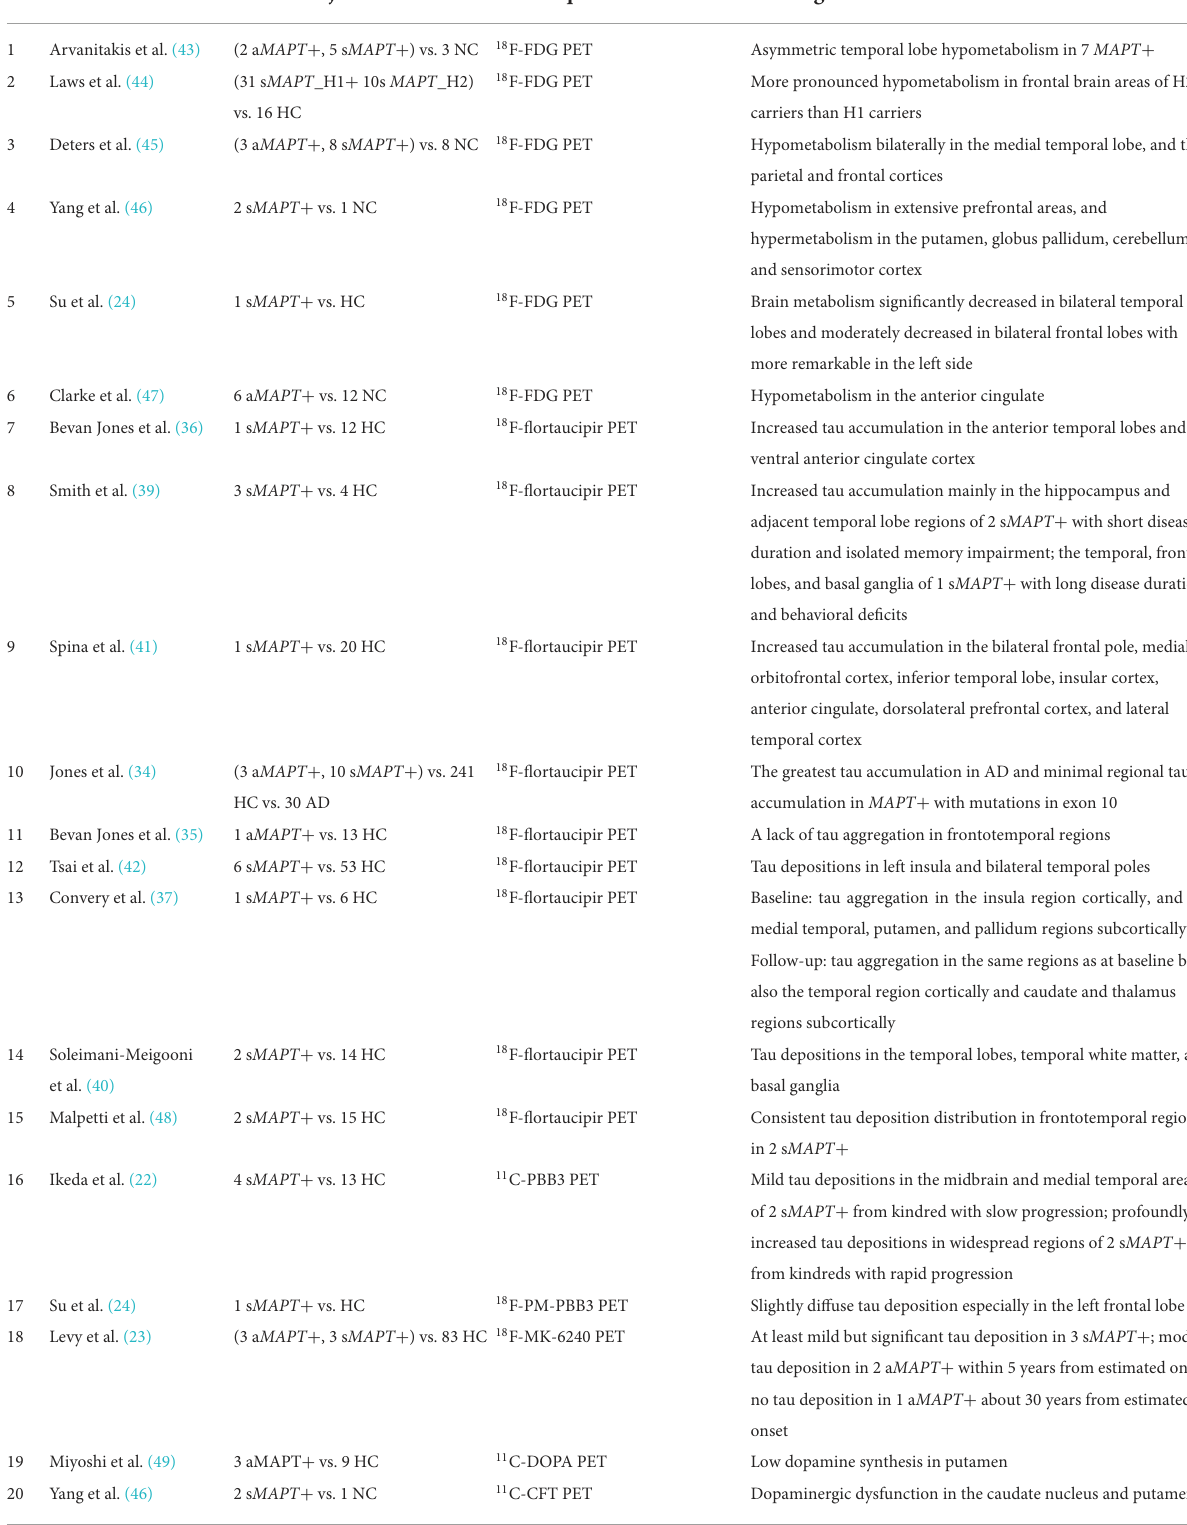
TABLE 1 Studies investigating MAPT mutation vs.